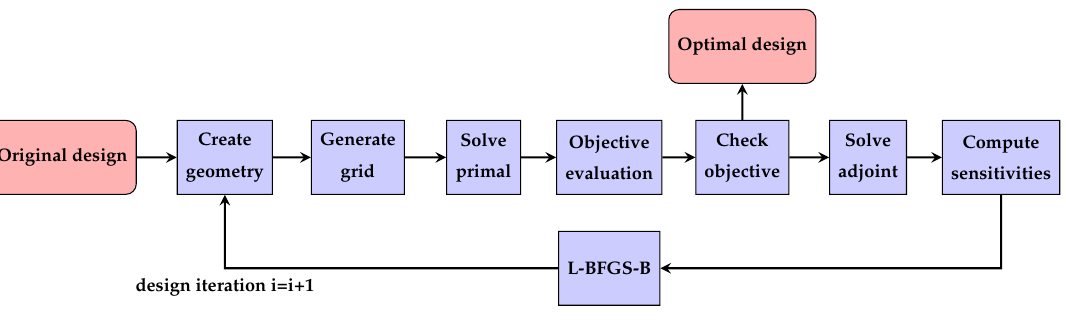
Figure 2. Optimization flow chart